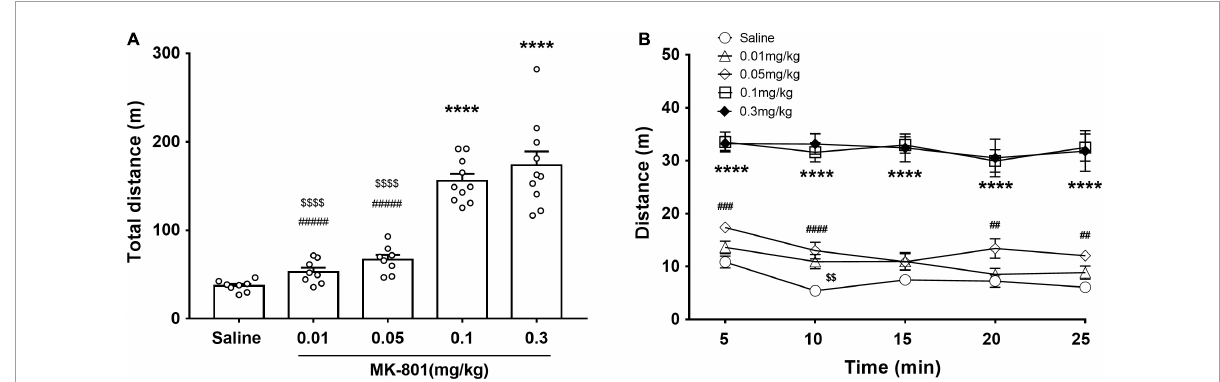
FIGURE2 Effects of MK-801 injection on the locomotor activity of mice in the OFT. MK-801 (0.01, 0.05, 0.1, and 0.3 mg/kg) or 0.9% NaCl were injected intraperitoneally 30 min prior to the OFT. The total distance of mice moved (A) and their progression in a 5 min bin during the last 25 min in the OFT (B) were analyzed. All values were expressed as mean ± SEM (Saline: n = 8; MK-801, 0.01 mg/kg: n = 8; 0.05 mg/kg: n = 8; 0.1 mg/kg: n = 10; 0.3 mg/kg: n = 10). **** p < 0 . 0001 vs. the saline group, $$ p < 0 . 01, $$$$ p < 0 . 0001 vs. the 0.1 mg/kg group, and ## p < 0 . 01, ### p < 0 . 001, #### p < 0 . 0001 vs. the 0.3 mg/kg group as revealed by Tukey’s multiple comparisons test.